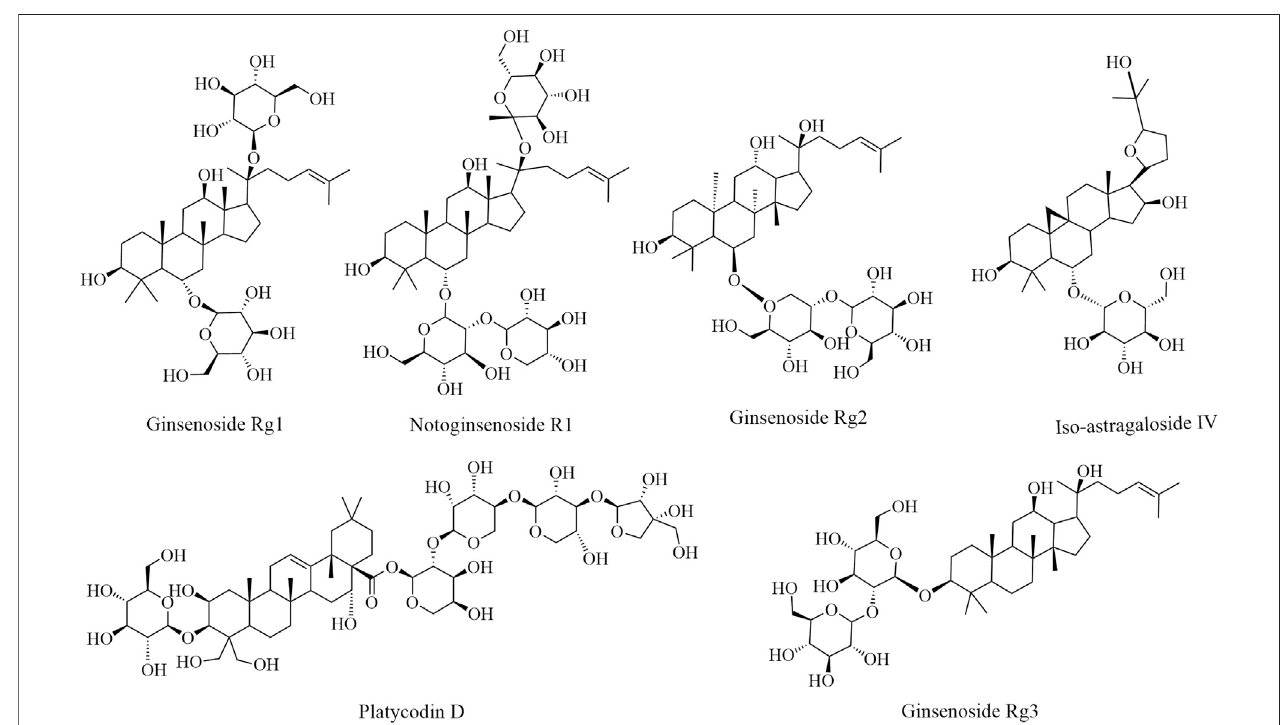
FIGURE 2 | The immune enhancement effects of saponins in plant-based functional foods.